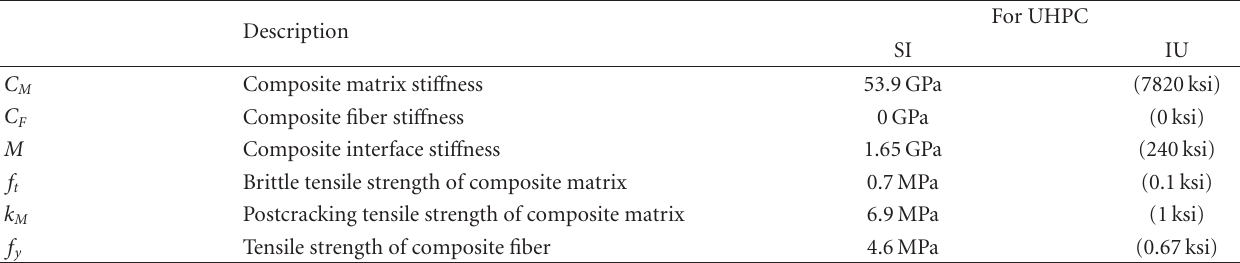
Table 1: Input parameters of the 1D UHPC model and typical values for Ductal derived from a notched tensile plate test